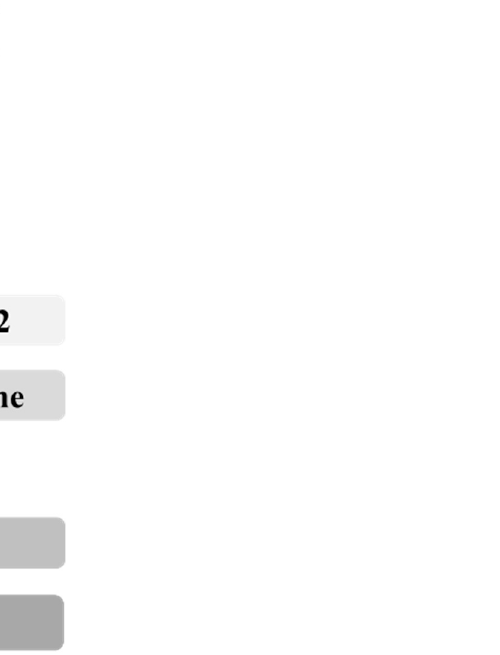
Figure 6. Predicted pathway for enhancement of anthocyanin accumulation by sound stimulation.